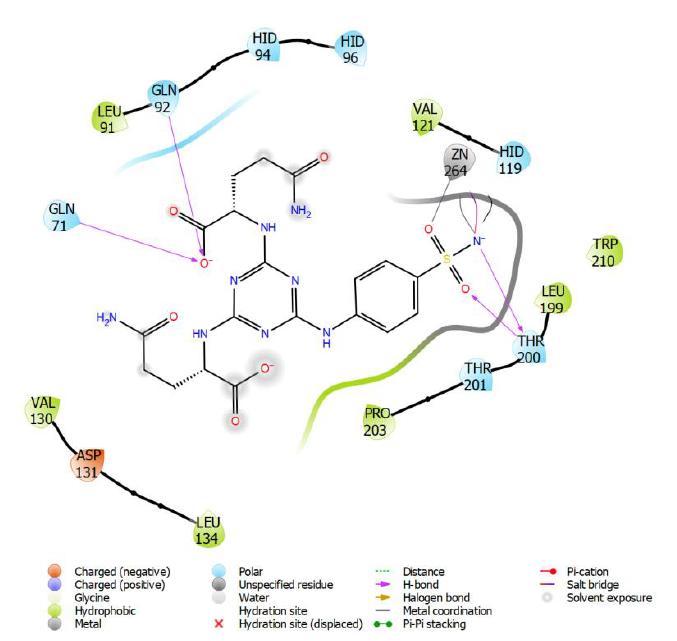
Figure 5. Intermolecular interactions of compound 7 (with Gln) docked into hCA IX.